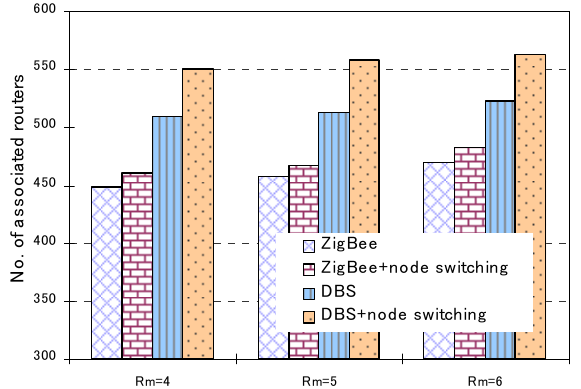
Figure 7. Number of associated routers for different